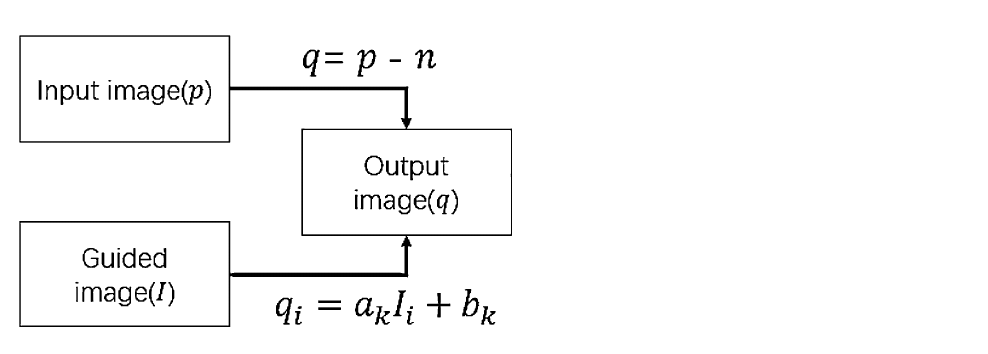
Figure 5. Guided filtering structure